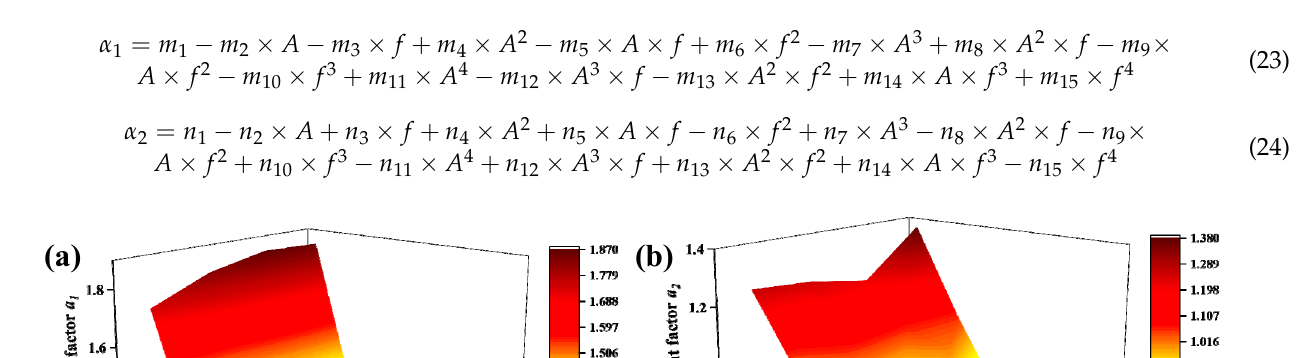
Table 8. Fitting results of the damping coefficient a 2